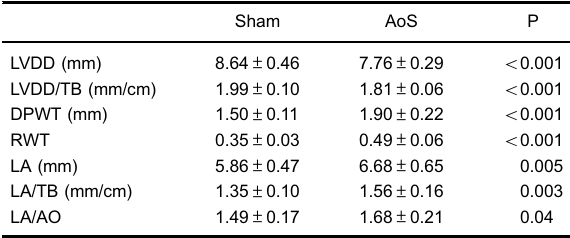
Table 2. Structural study by echocardiogram.